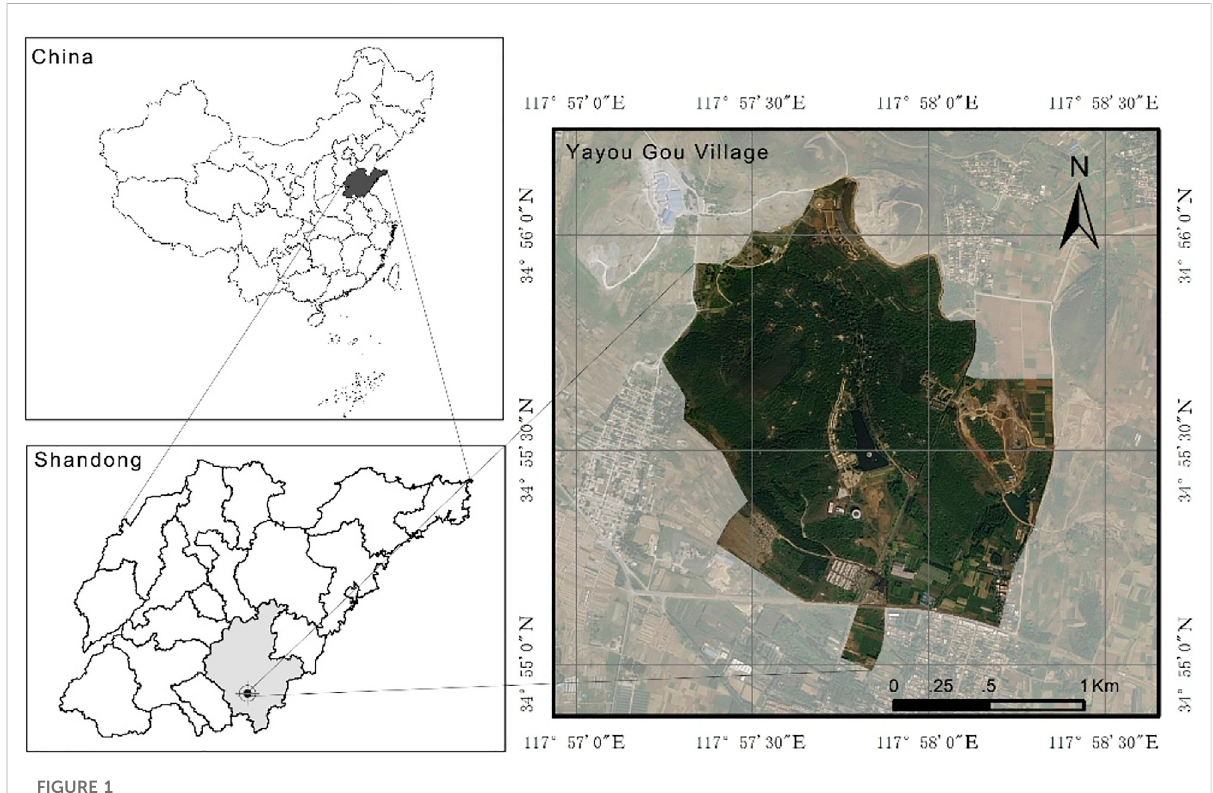
FIGURE 1 Location of the study area, Yayou Gou Village in Shandong Province,